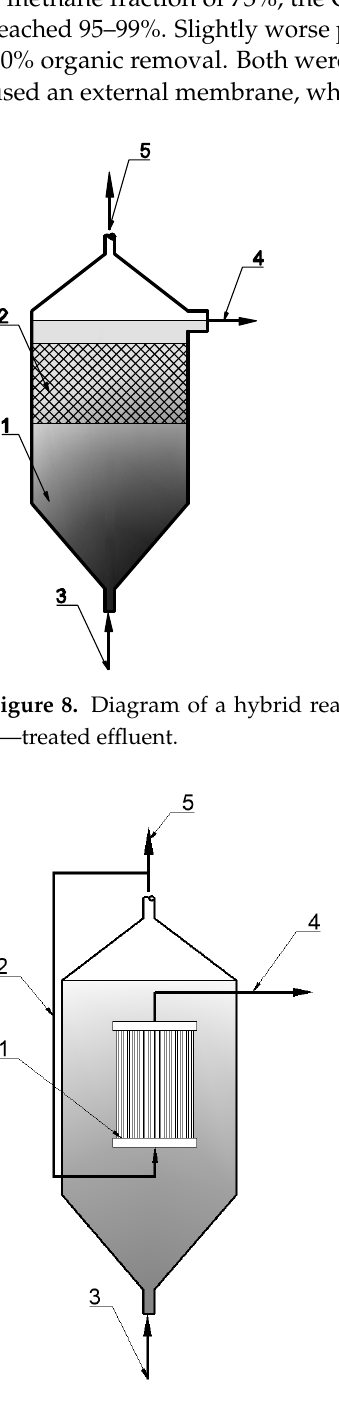
Figure 9. Diagram of an AnMBR: 1—membrane module, 2—biogas recycle for membrane sourcing, 3—raw wastewater inflow, 4—permeate, 5—biogas outflow.